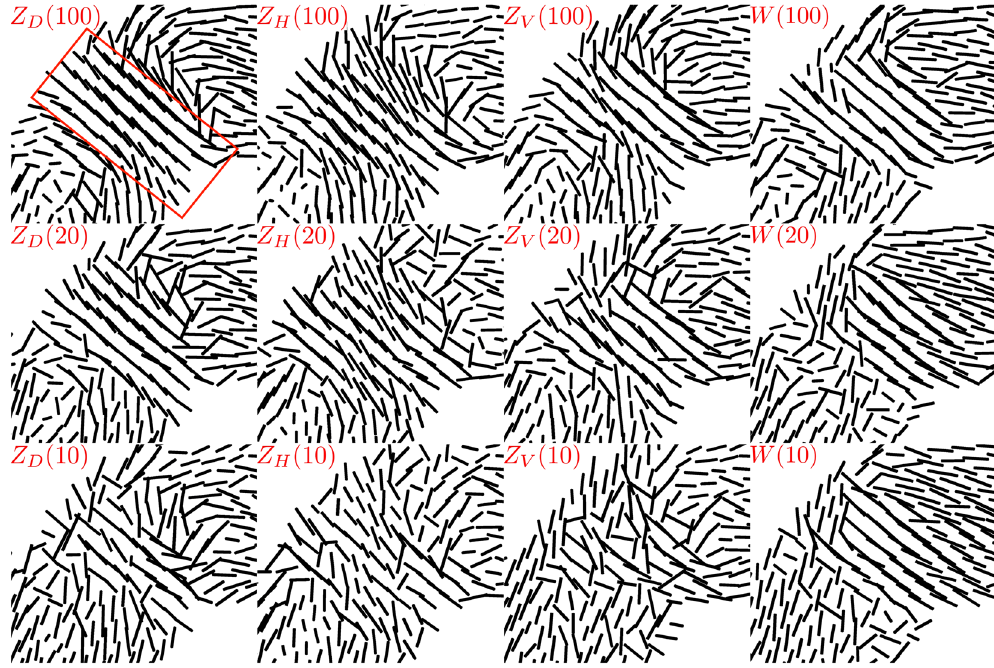
Figure 8. Structure orientations calculated using AXDT in the region-of-interest (indicated by the red box in Fig. 7(c)) for different acquisition schemes. Each column corresponds to acquisition schemes and every row shows the four schemes with the same value of N . The red box indicates the region-of-interest used for calculating the Experimental